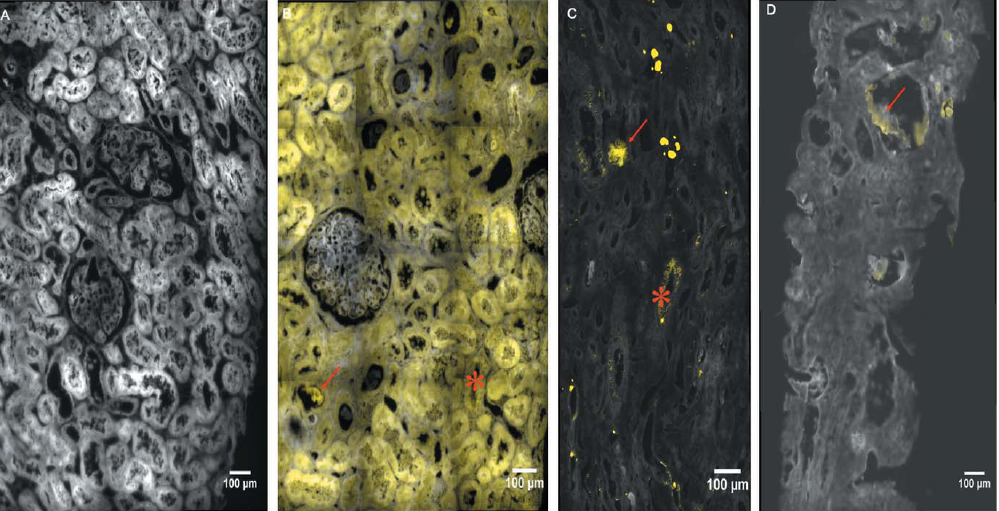
Figure 2 Synchrotron WFDUV mapping of typical kidney biopsies. The signal (yellow) was obtained after subtraction of the 412–438 nm channel and 327–353 nm channel fluorescence map. The background signal (grey) was obtained using the 327–353 nm channel (aromatic amino-acid fluorescence). (A) Normal kidney. (B) Primary hyperoxaluria patients present large CaOx crystals (arrow), small punctiform structures compatible with microcrystals (asterisks) and a diffuse signal in the cytoplasm of tubular cells. (C) Secondary hyperoxaluria have either large deposits (arrow) and punctiform signals (asterisks) without clear tubular diffuse distribution or (D) only large deposits